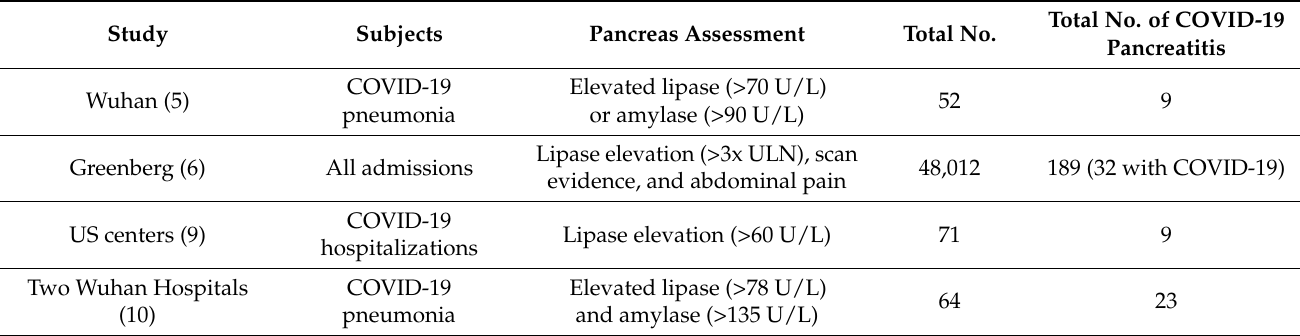
Figure 1. Flow chart of the selected literature work included in the systemic review. Table 1. Summary of studies discussing acute pancreatitis association with